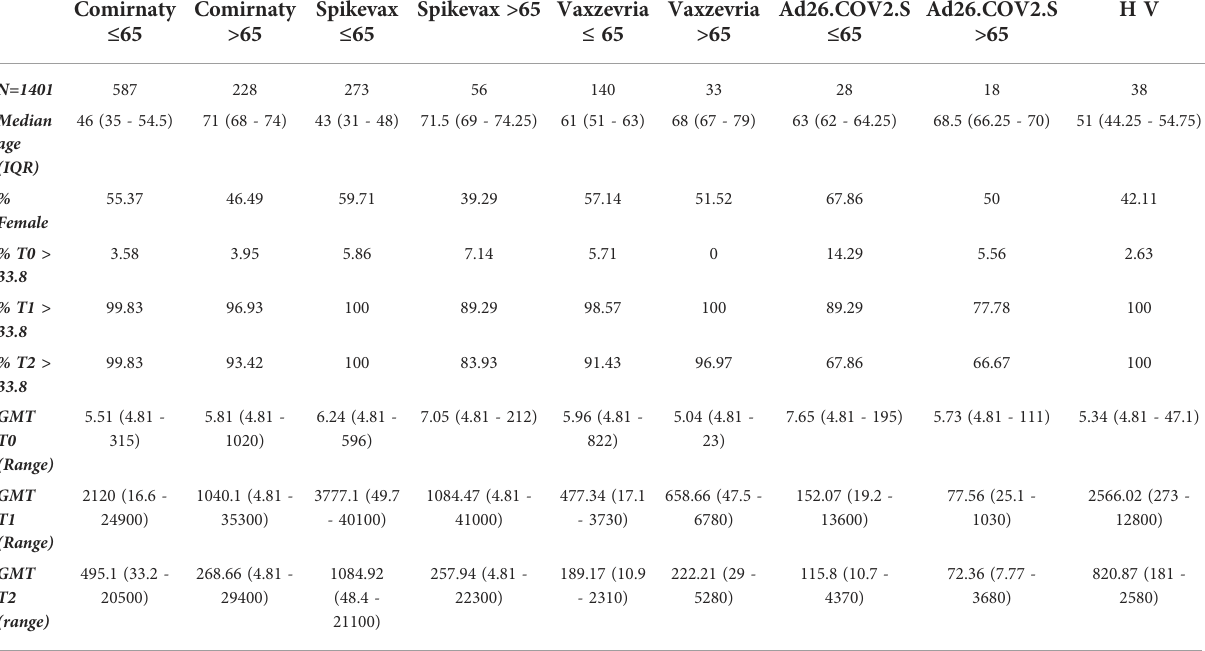
TABLE 1 Demographic characteristics, baseline values and humoral immune response induced at T1 and T2 time-points by different vaccines in healthy adults and frail elderly individuals without any previously reported COVID-19 diagnosis. Comirnaty Comirnaty ≤ 65